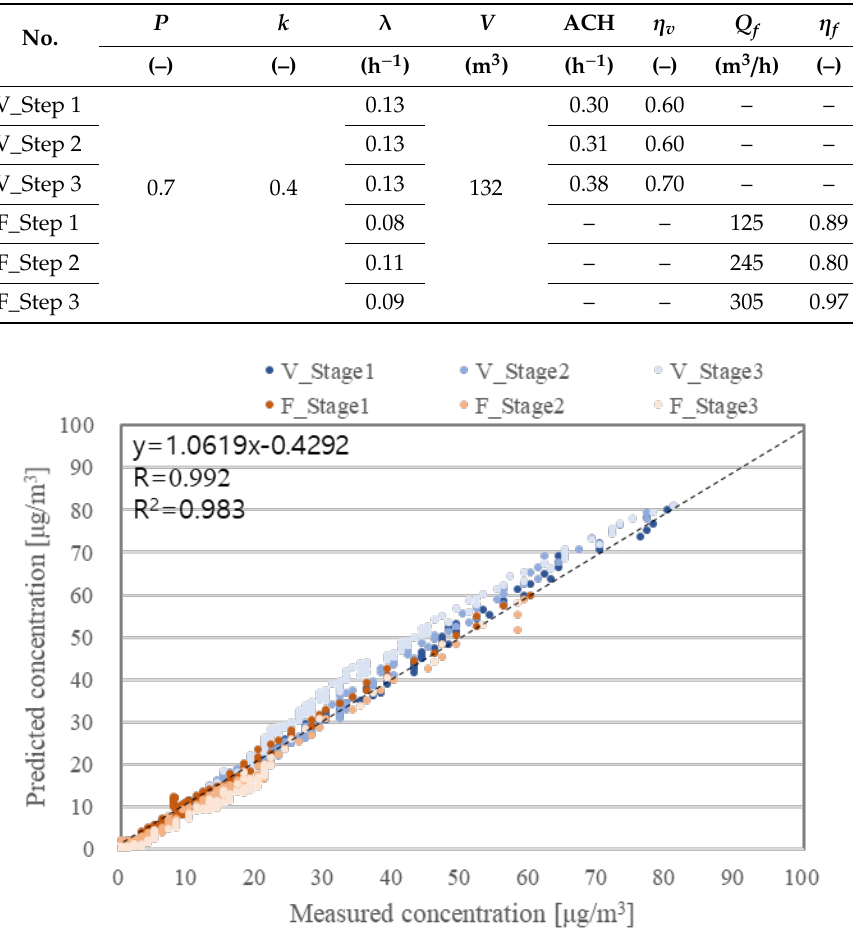
Figure 7. Comparison of measured and predicted PM2.5 concentration.